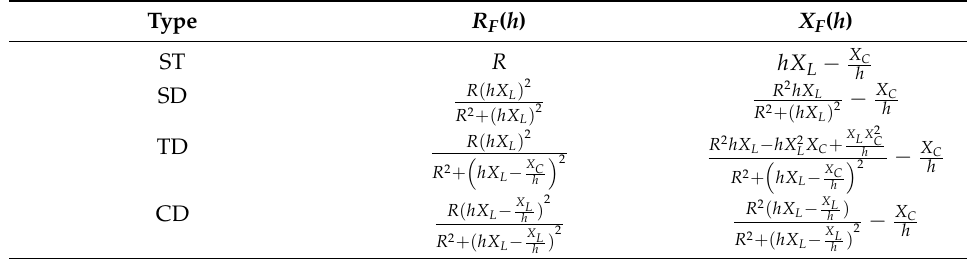
Table 1. The harmonic impedance of